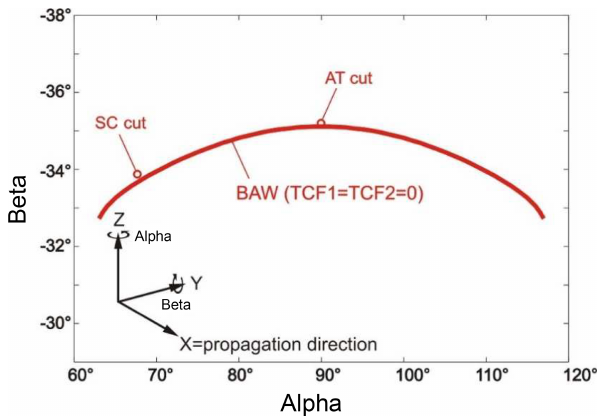
Figure 2. Two preferential orientations of quartz crystals for TSM applications: AT and SC cuts represent directions with small first- and second-order temperature coefficients of frequency constant (TCF). Besides this, the SC cut is stress-insensitive. The initial ( x , y , and z ) axes form the physical coordinate system, used here for subsequent rotations about z axis and thereby changed y axis. The x axis after both rotations denotes the BAW propagation direction normal for the plate